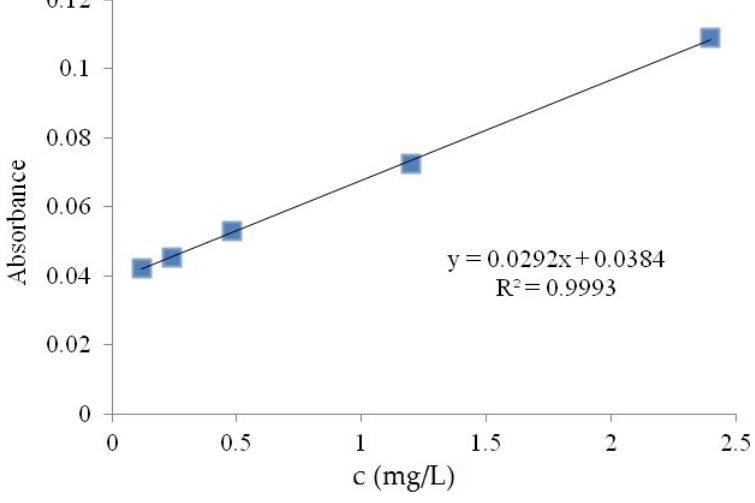
Figure 1. The standard curve of Rhodamine B aqueous solution.